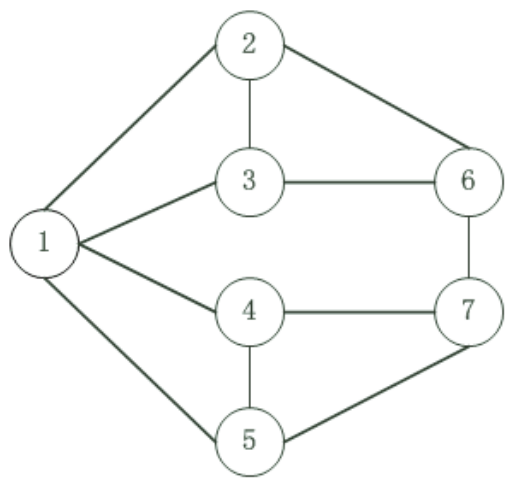
Figure 1: An interconnection topology graph 𝐺 with 7